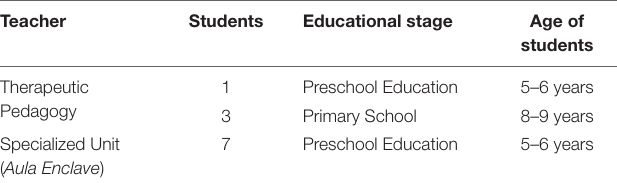
TABLE 1 | Participating students per